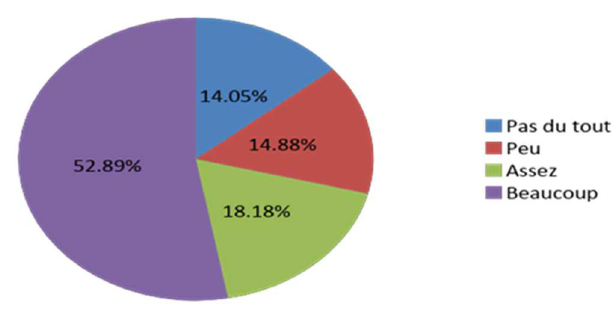
Fig. 1 La perception par les élèves de l’impact du TBI sur leur envie d’aller au tableau